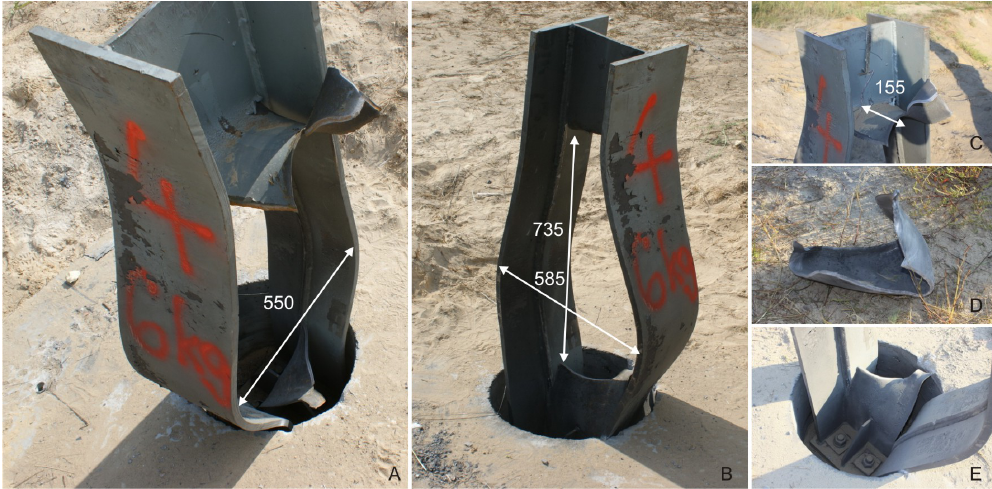
Figure 6. An effect of close-in explosion of 6 kg TNT on the steel